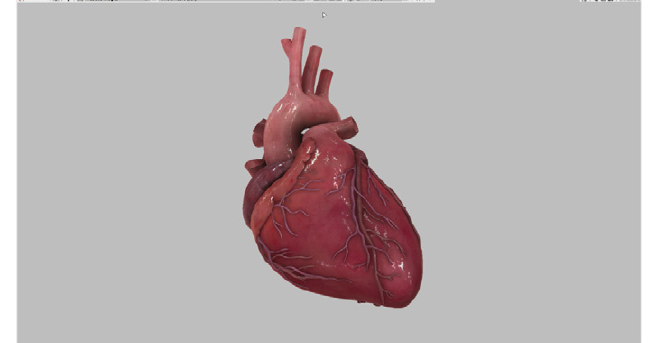
Figure. 4 Heart model with surface textures